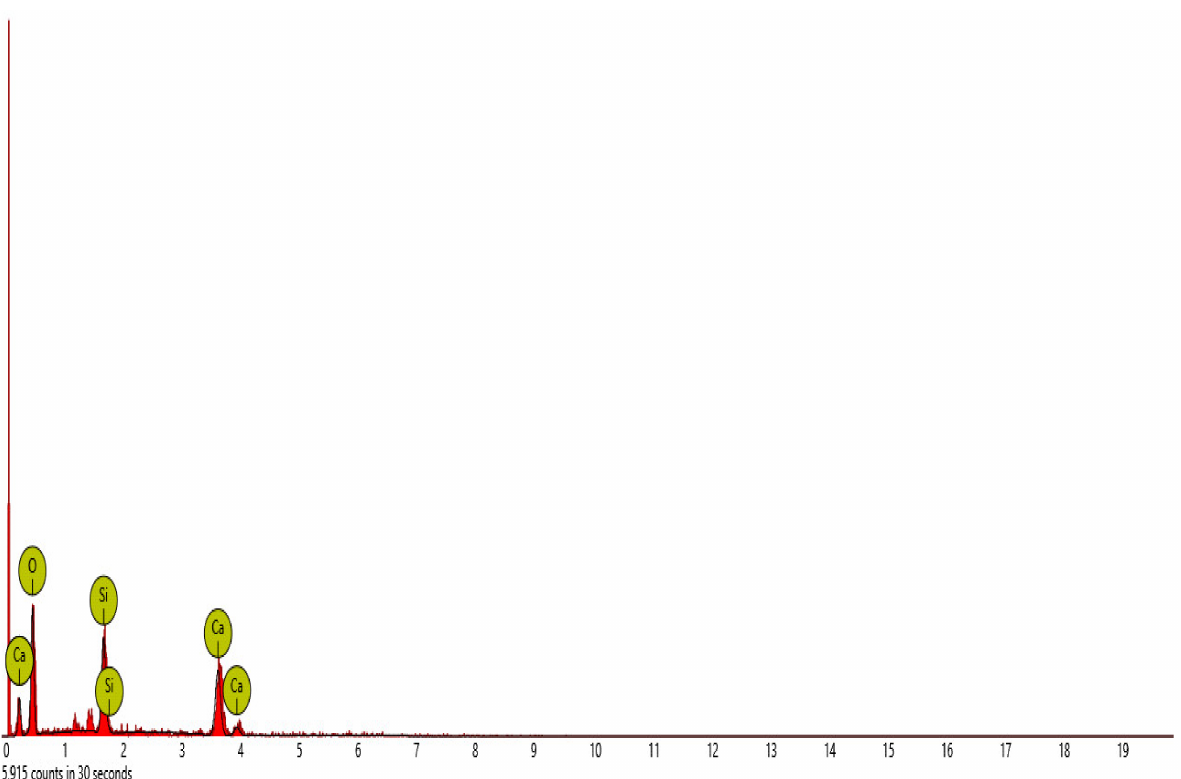
Figure 18. Graphical charts illustrating the atomic quantifications and the weights of the elements discovered from the EDS spectra of pervious concrete spot 1 sample Y 4 .